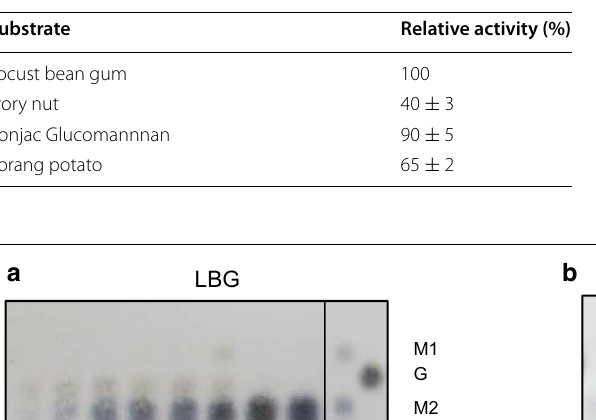
Table 2 Effect of various substrates on the activity of ManKs_4-555 compared to LBG